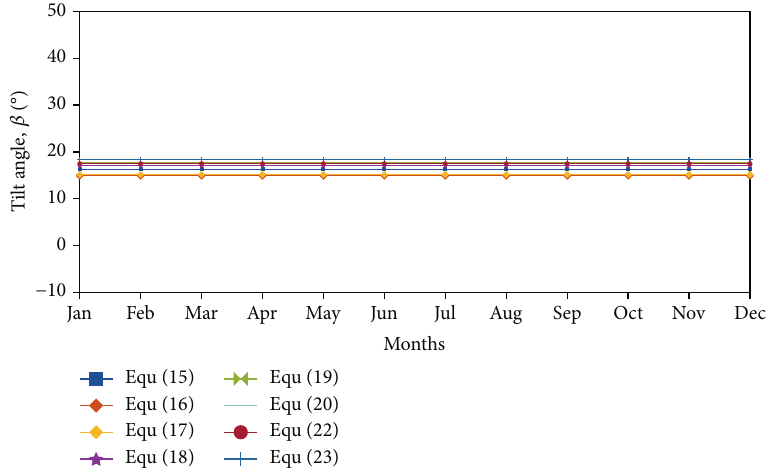
Figure 8: Yearly optimal tilt angle evaluated by isotropic and anisotropic model for Bahir Dar